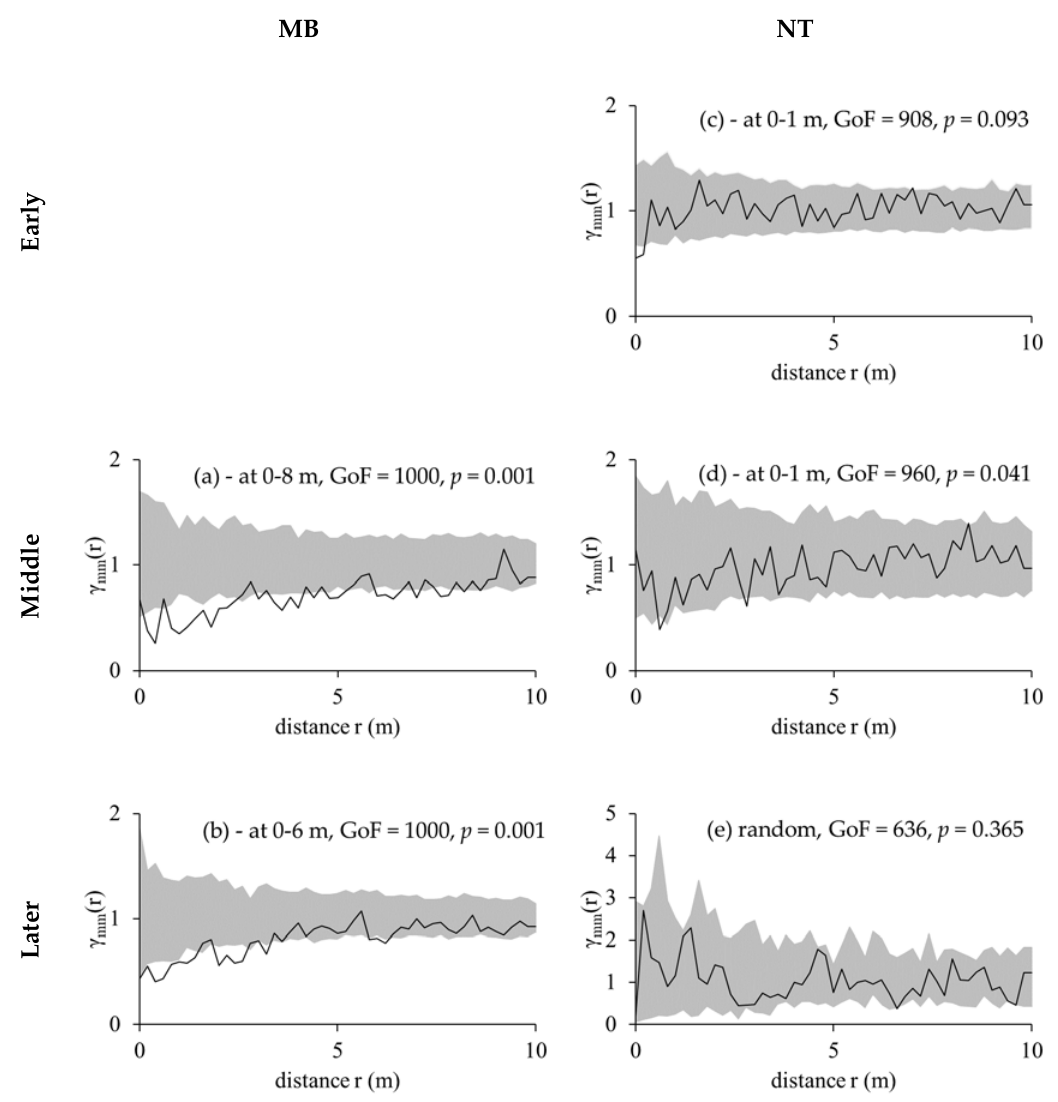
Figure 5. Marked variogram functions of MB (moso bamboo, a , b ) and NT (native forest, c , d , e ) in different bamboo expansionary phases for all of nine plots (the early, middle, and later phases were each represented by three plots). Black solid lines denote the observed pair-correlation function. The envelopes (grey areas) denote the ranges of the mark differentiation function of a random assignment of tree size marks and were constructed using 99% quantiles of 999 Monte Carlo simulations based on the independent marking null model. Observed lines that fall above the simulation envelopes indicate an aggregation of different tree sizes. If the rank of the test was larger than 950 (990), the data showed a significant or extremely significant departure from the null model with an error rate a = 0.05 (extremely significant departure, a = 0.01).